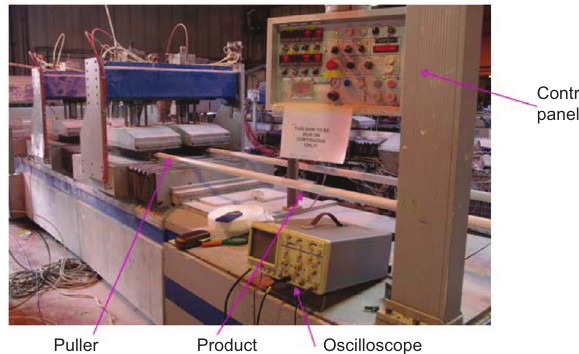
Figure 6 Pultrusion machine with oscilloscope attached to the multimeter. Calculations of specific energy